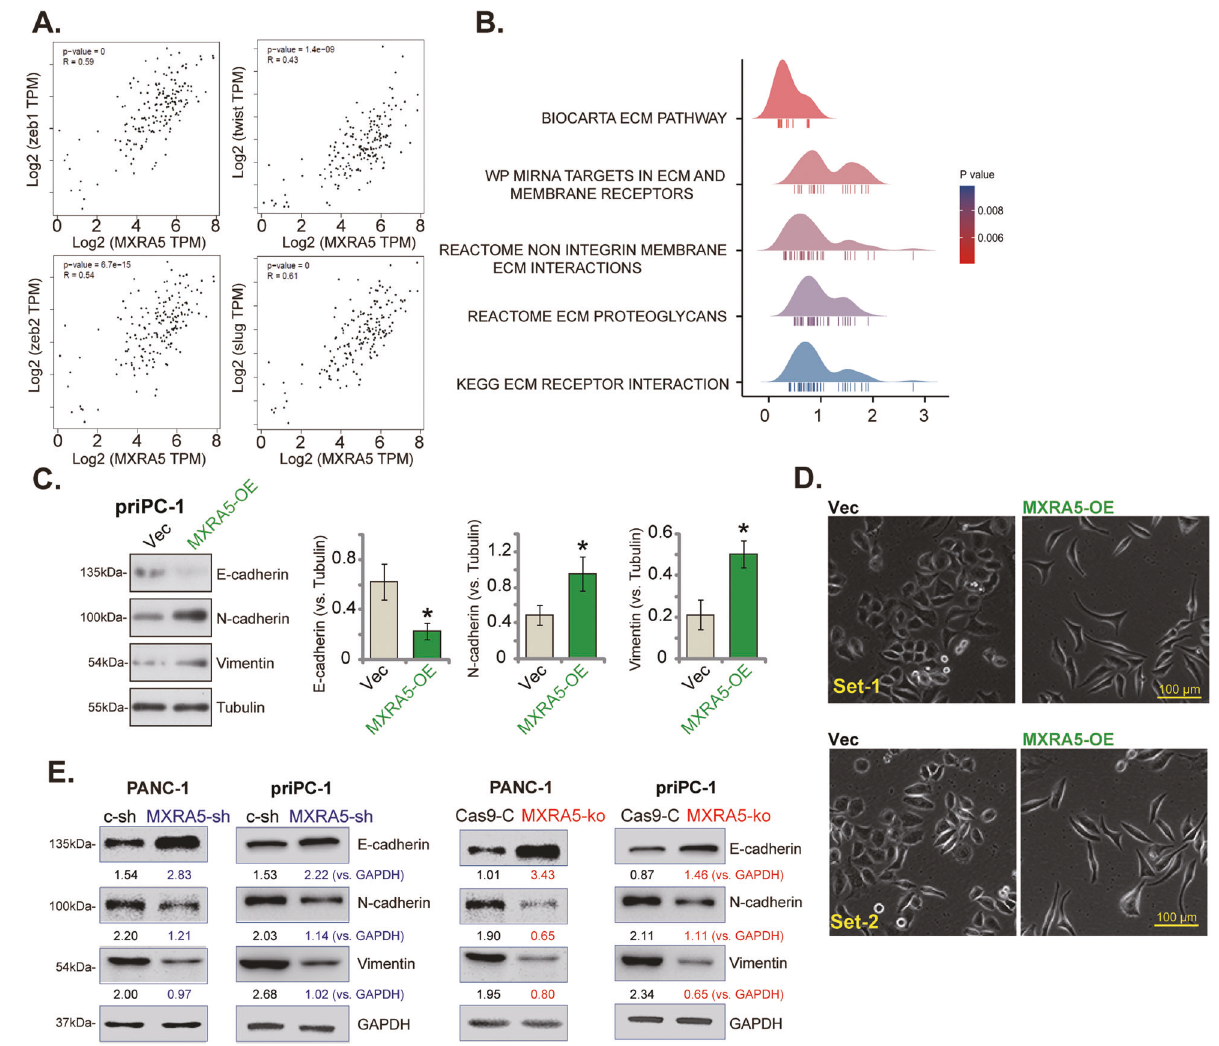
Fig. 5 MXRA5 promotes epithelial-to-mesenchymal cell transition (EMT) in pancreatic cancer cells. Scatter plots of correlation between MXRA5 mRNA expression and EMT marker genes from the TCGA-PAAD database ( A ). Ridge plot shows the correlation between MXRA5 mRNA expression and ECM signature markers in pancreatic cancer ( B ). Puromycin-selected priPC-1 primary human pancreatic cancer cells or PANC-1 cells, with the lentiviral MXRA5 overexpression construct ( “ MXRA5-OE ” ), the corresponding vector ( “ Vec ” ), MXRA5-sh-S1 ( “ MXRA5-sh ” ), the scramble control shRNA ( “ c-sh ” ), the sgRNA-CRISPR/dCas-9 MXRA5-KO lentiviral construct ( “ MXRA5-ko ” ) or Cas9 control construct ( “ Cas9-C ” ), were cultured and expression of EMT marker proteins was tested ( C and E ). The characteristic EMT morphology in MARA5-overexpressed priPC-1 primary cancer cells were presented ( D ). Error bars stand for mean ± standard deviation (SD, n = 5). “ TPM ” stands for transcripts per million. “ ECM ” stands for extracellular matrix. * P < 0.05 versus “ Vec ” cells. Experiments in this fi gure were repeated fi ve times. Scale bar = 100 μ MXRA5 in priPC-1 primary cancer cells increased phosphorylation of Akt (Ser-473) and S6 (Fig. 6E). Conversely, shRNA-induced knock- down or CRISPR/Cas9-induced knockout of MXRA5 suppressed the phosphorylations of Akt (Ser-473) and S6 in priPC-1 primary cancer cells (Fig. 6F, G). Therefore MXRA5 is important for Akt-mTOR activation in pancreatic cancer cells. Treatment with LY294002, the PI3K-Akt-mTOR pan inhibitor [48], largely inhibited proliferation (EdU incorporation, Fig. 6H), migration (Fig. 6I) and invasion (Fig. 6J) in OE-MXRA5 priPC-1 cells. Moreover, N-Cadherin and vimentin protein downregulation but E-Cadherin protein upregulation were detected in LY-294002- treated OE-MXRA5 priPC-1 cells (Fig. 6K). These results supported that Akt-mTOR activation is important for MXRA5-driven priPC-1 cell proliferation, mobility and EMT. Considering that MXRA5-associated DEGs are enriched in focal adhesion (Fig. 6A, B) and activation of focal adhesion kinase (FAK)